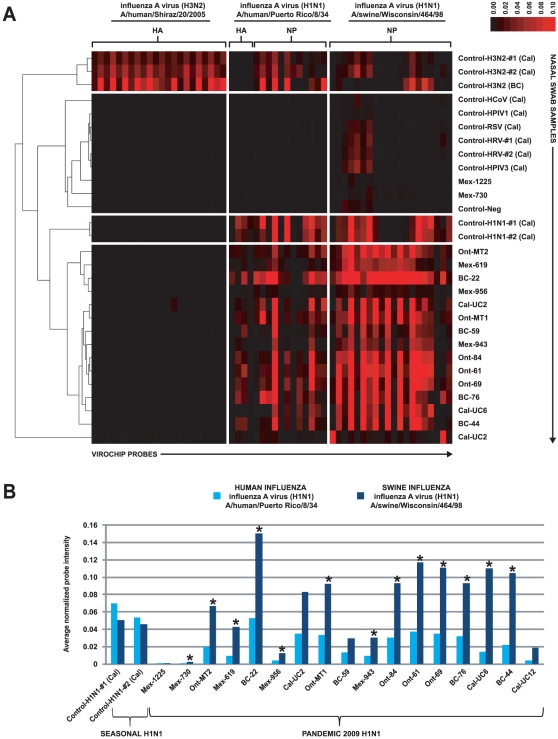
Virochip microarray analysis of samples from patients with influenza-like illness.(A) Cluster analysis and heat map profile for 29 nasopharyngeal swab samples analyzed using the Virochip. Samples (y-axis) and probes on the Virochip designed a priori and derived from 3 influenza A strains (x-axis) are clustered using hierarchical clustering. The red color saturation indicates the magnitude of normalized probe intensity. (B) For each sample, the average normalized probe intensity for Virochip probes corresponding to human H1N1 influenza A (light blue) or swine H1N1 influenza A (dark blue) is shown. The asterisks denote samples for which the difference in probe intensity is significant by t-test analysis (p<0.05). Abbreviations: HA, hemagglutinin; NP, nucleoprotein; Cal, California; HRV, human rhinovirus; HPIV1, human parainfluenza virus 1; HCoV, human coronavirus; HPIV3, human parainfluenza virus 3; RSV, respiratory syncytial virus; Neg, negative.